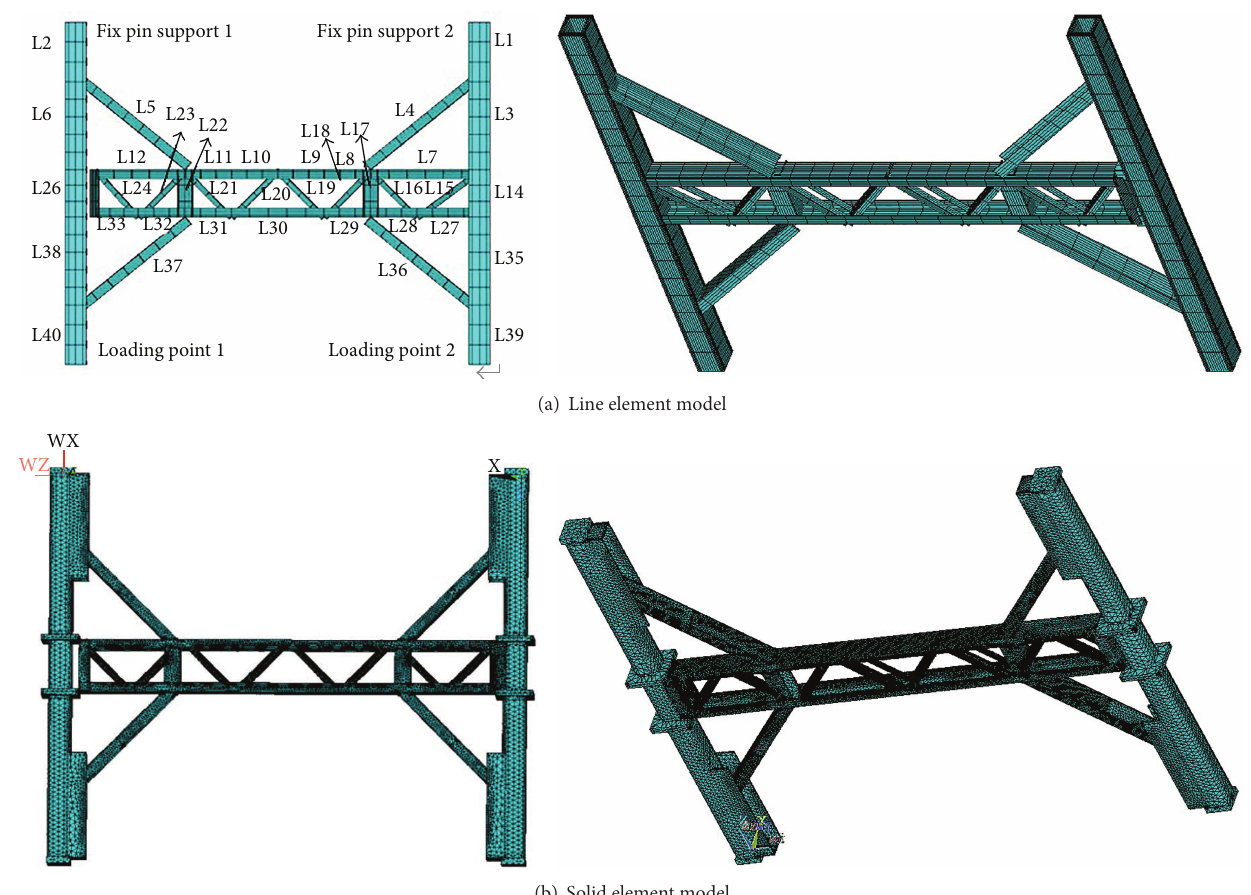
Figure 8: Element model and member